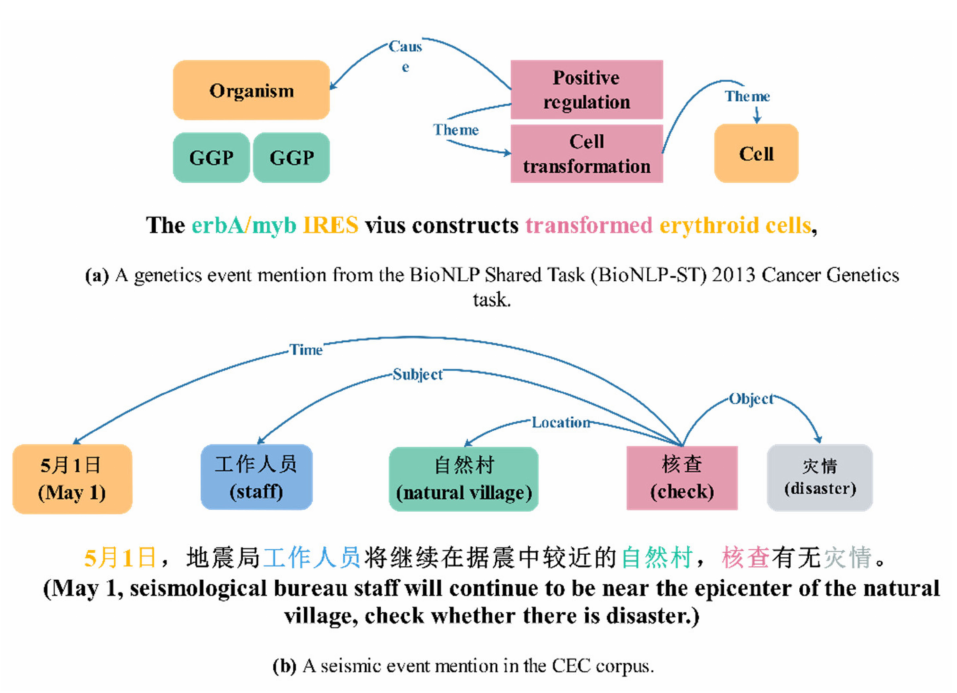
Figure 1. An example comparison between the genetics event mention and the Chinese emergency event